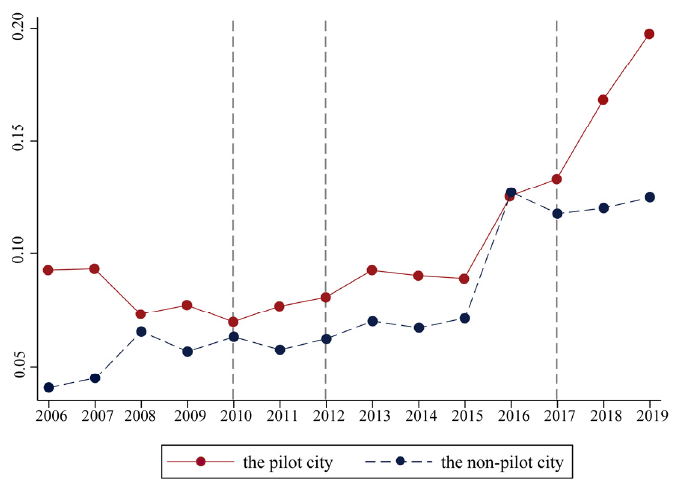
Figure 2. The GUEUL in the pilot city and non-pilot city.